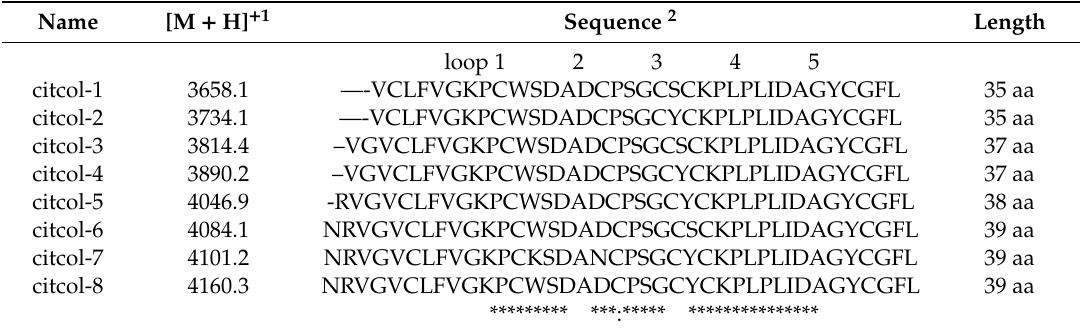
Table 1. Properties and sequence comparison of isolated citcol